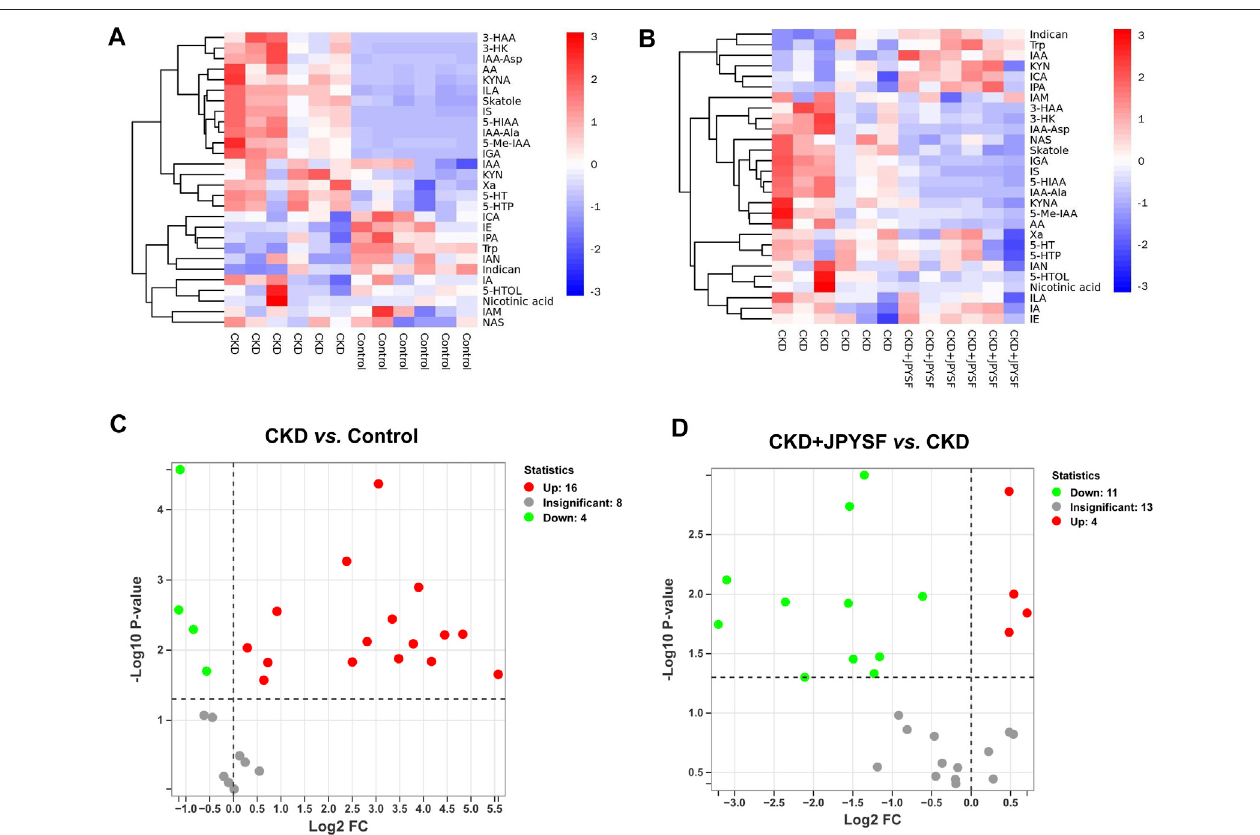
FIGURE 4 | Differences in tryptophan metabolites content in different groups. (A) Heatmap analysis between the control group and the CKD group. (B) Heatmap analysis between the CKD group and the CKD + JPYSF group. In the heatmap, red represents increase and blue represents decrease. (C) Volcano plot analysis of the CKD group compared with the control group. (D) Volcano plot analysis of the CKD + JPYSF group compared with the CKD group. In the volcano plot, red represents signi fi cant up-regulation, green represents signi fi cant down-regulation, and grey represents insigni fi cant difference.